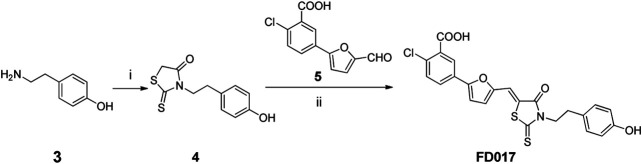
Synthesis of FD017. Reagents and conditions: (i) bis(carboxymethyl) trithiocarbonate, Et3N, i-PrOH, MW, 90°C, 45 min; (ii) CH3CO2NH4, EtOH, reflux, 2 h.